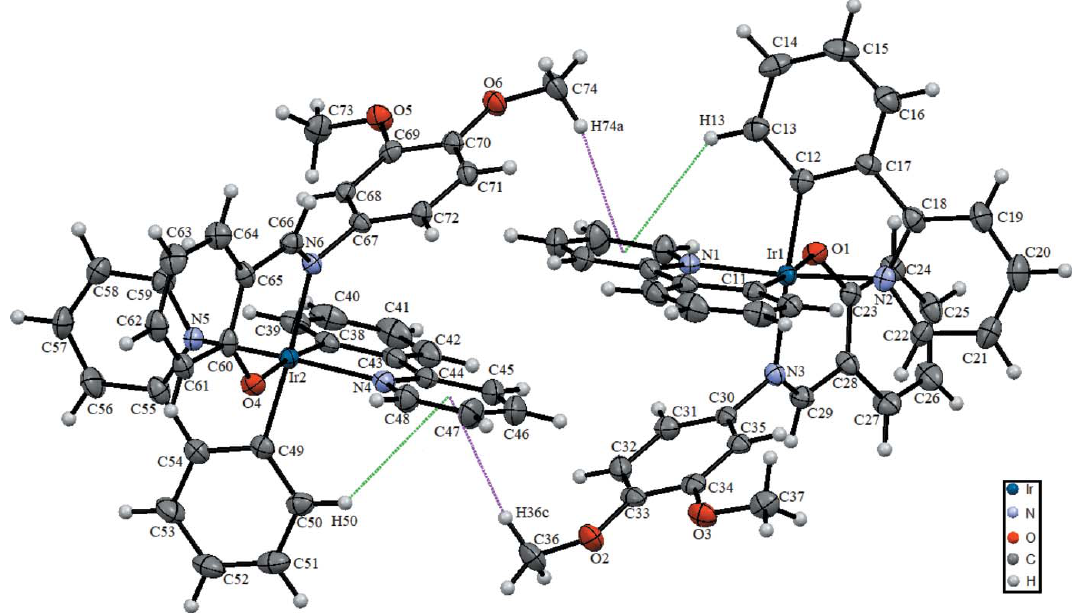
Figure 1 View of the asymmetric unit of the title compound with the atom-numbering scheme. Displacement ellipsoids are drawn at the 50% probability level. Purple and green dashed lines represent intra- and intermolecular C—H (cid:2)(cid:2)(cid:2) (cid:2) interactions, respectively. Solvent molecules are omitted for clarity.